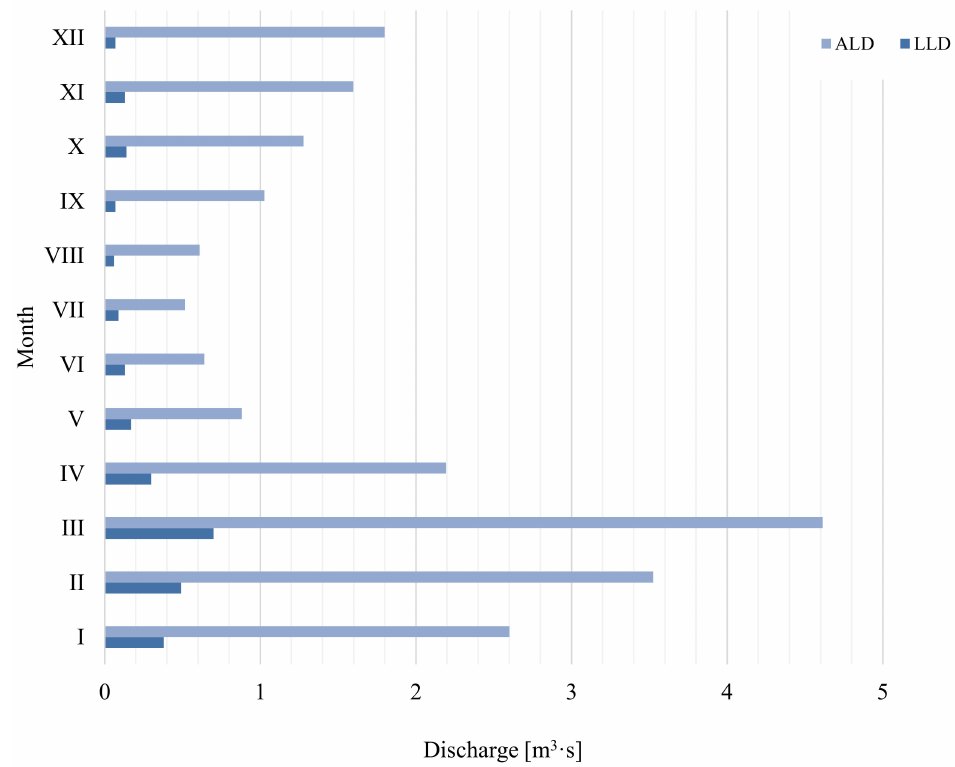
Figure 5. Monthly flow variability in the Orla River in the multiannual period of 1981–2010 at the Korze´nsko gauge cross-section. ( ALD—average discharge from the lowest, LLD—the lowest from lowest discharges